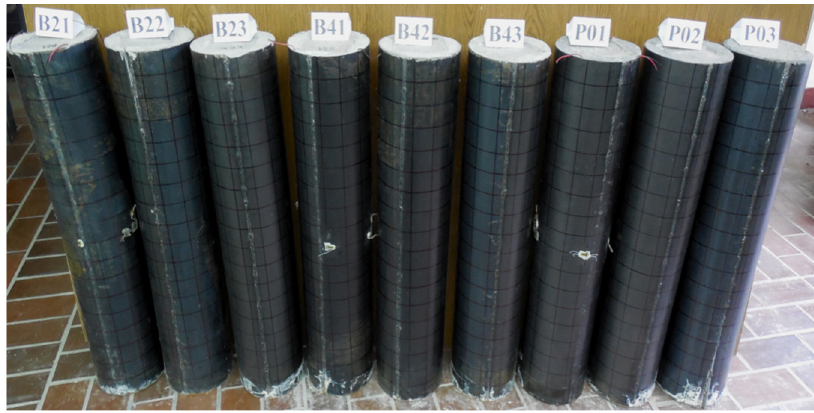
Figure 13. Strengthened column models after the experiment.